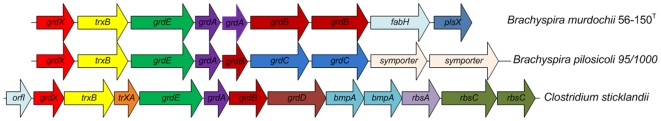
Physical map of the glycine reductase genes and adjacent regions in B. pilosicoli 95/1000, B. murdochii 56-150T and Clostridium sticklandii.